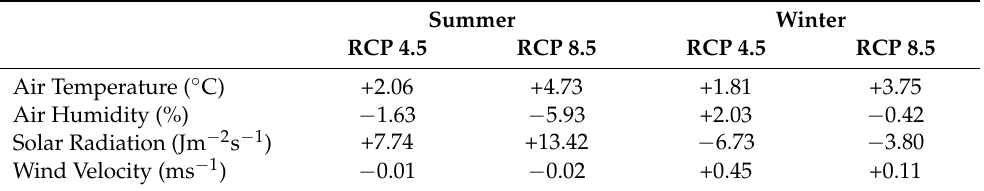
Table 2. Changes at the atmospheric boundary inputs applied in the simulations of future